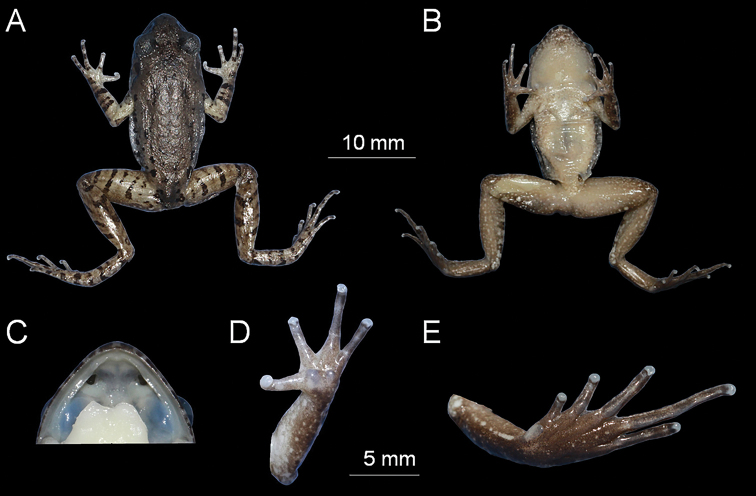
The holotype specimen CIBCS20190518047 of Leptobrachella
chishuiensis sp. nov. in preservative A dorsal view B ventral view C frontal view of tongue D ventral view of hand E ventral view of foot.